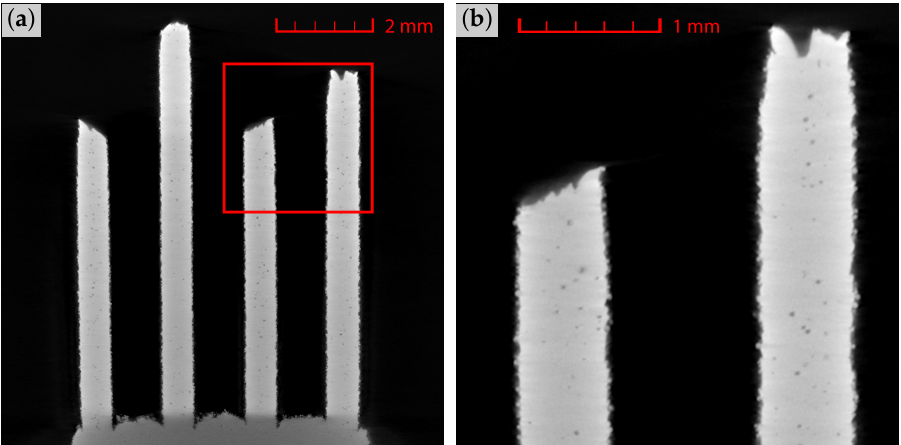
Figure 7. Micro-CT scan of the solid sample L10D07 with porosity. ( a ) Overview of all four struts. ( b ) Magnification with visible pores